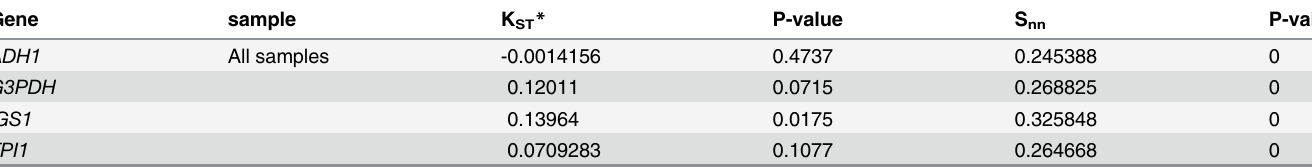
Table 3. Significance of K ST * and S nn tests for geographic